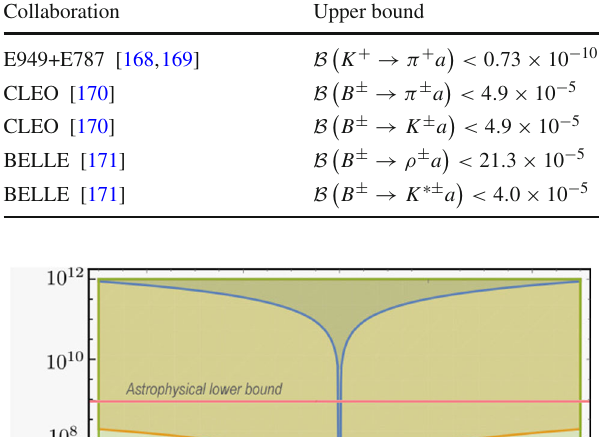
Table 4 These inequalities come from the window for new physics in the branching ratio uncertainty of the meson decay in a pair ¯ νν Collaboration